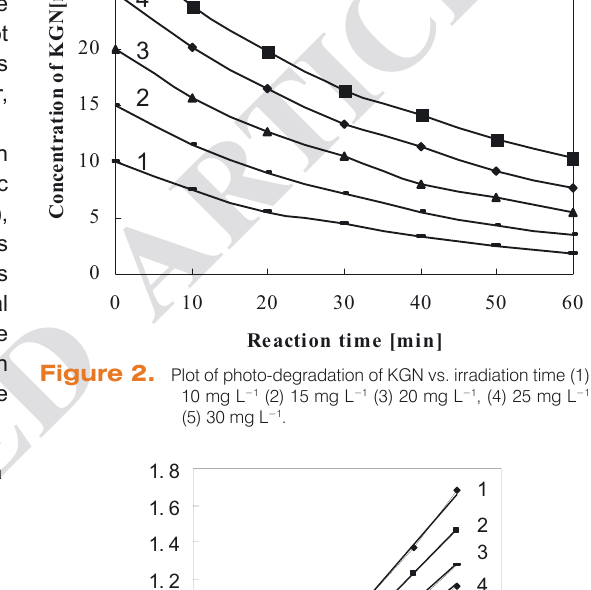
Figure 1. Structure of Reactive Orange